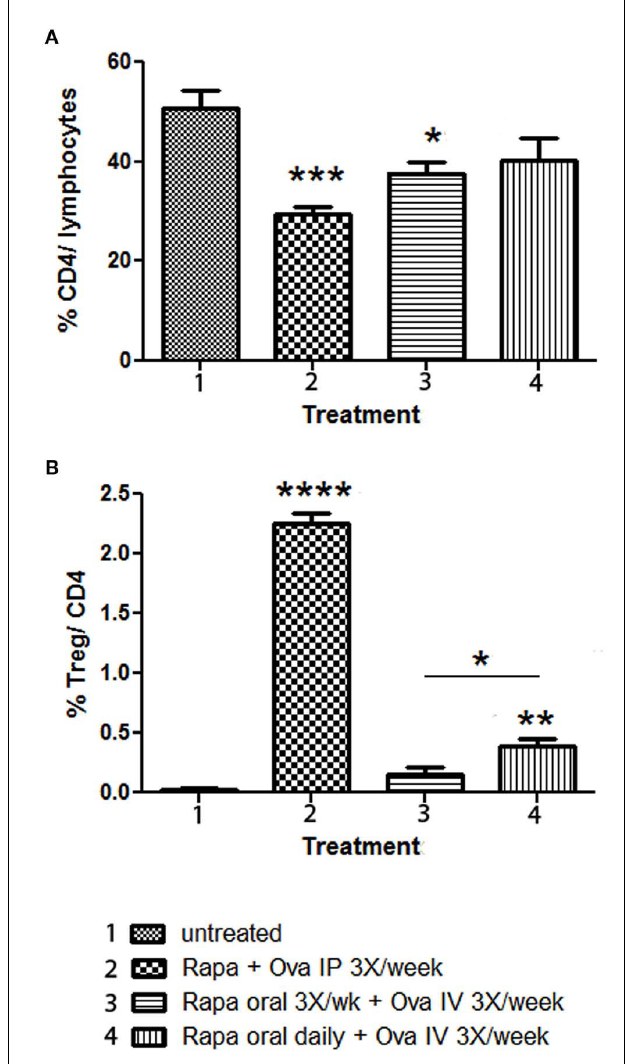
FIGURE 4 | Comparison of Rapa/specific peptide tolerization protocol using different routes and schedules of drug administration. DO.11.10-tg Rag − / − mice ( n = 4 per group) were treated for 3weeks with Rapa/ova-specific peptide, after which the spleens were harvested, and flow cytometry was used to determine: (A) percentage of CD4 + T cells of total gated splenocytes, and (B) percentage of CD25 + FoxP3 + cells of CD4 + T cells. Statistically significant differences between each group and untreated (naïve) control mice are indicated as * P < 0.05, ** P < 0.01, *** P < 0.001, and **** P < 0.0001. In (B) , a statistically significant difference between mice that received rapamycin orally three-times per week or daily is also